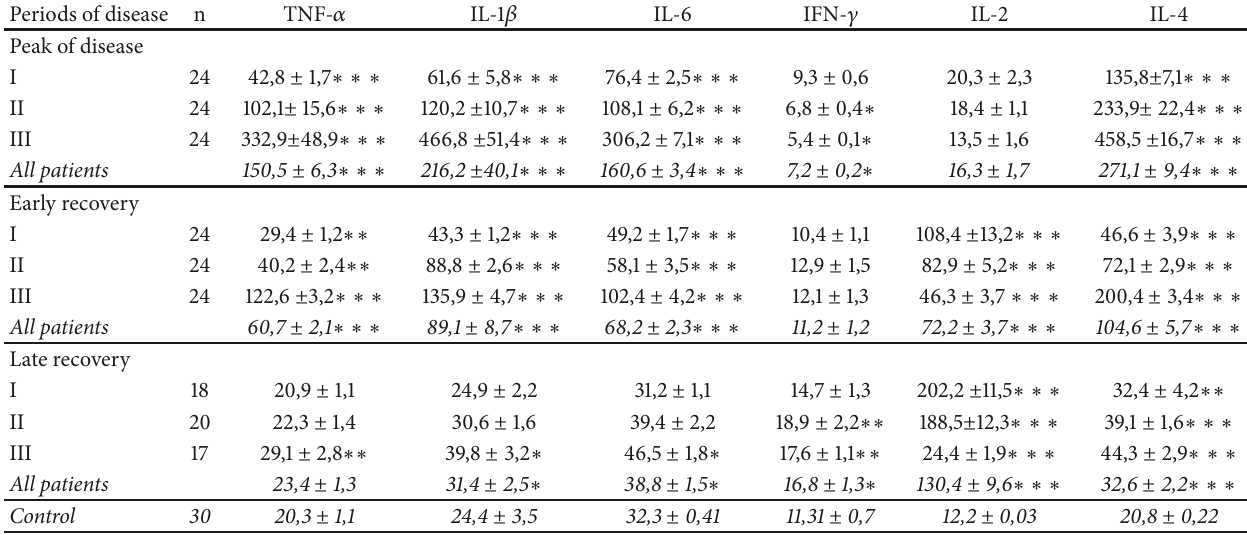
Table 1: Contents of plasma cytokines in Plasmodium falciparum malaria in children (Pg/ml). Periods of